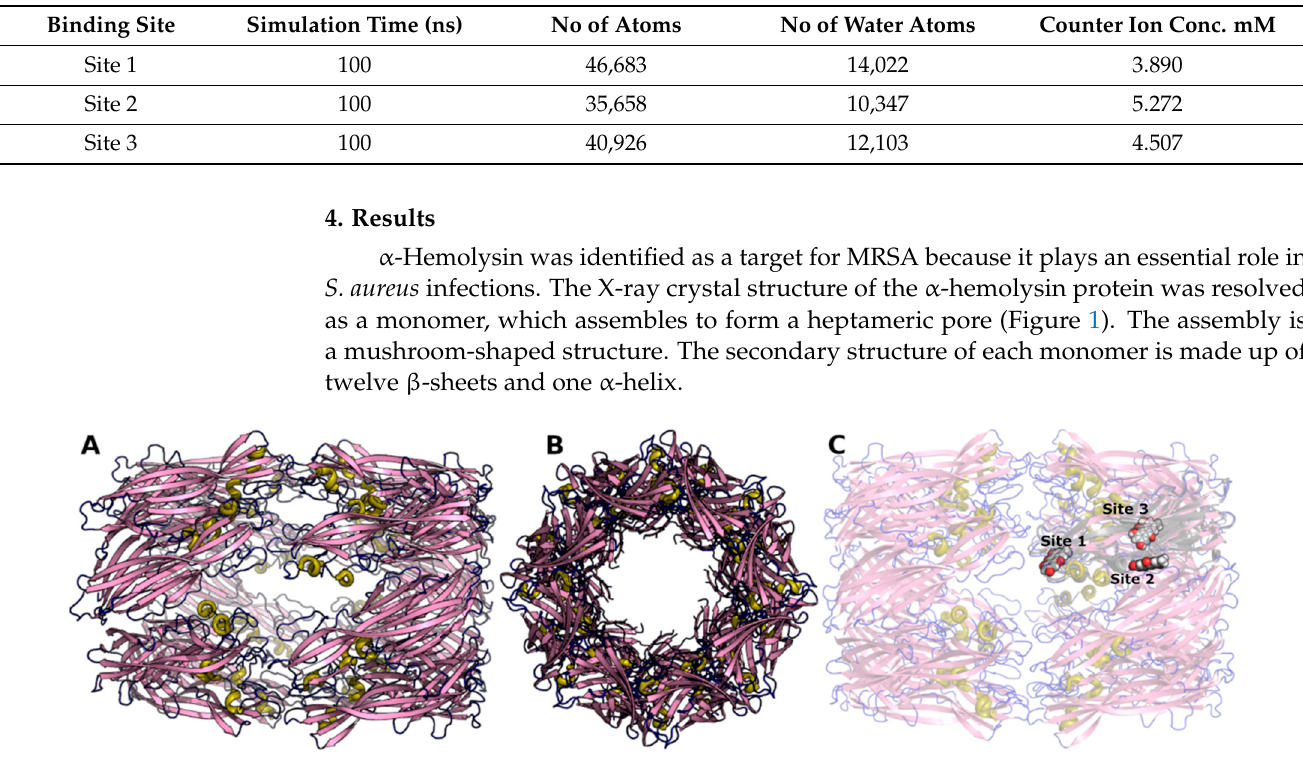
Figure 1. α -Hemolysin structure. ( A ). A side view. ( B ). A top view. ( C ). The possible ligand binding